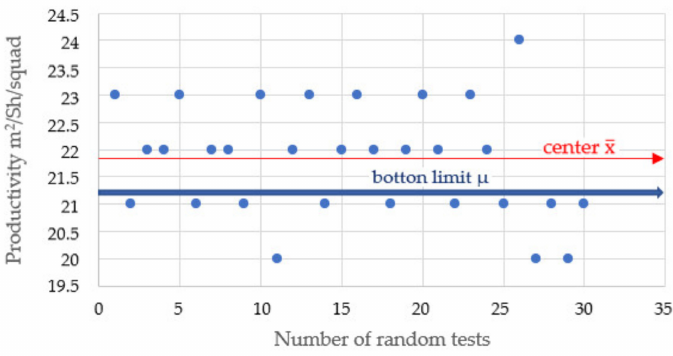
Figure 7. Graphic illustration of formwork performances, including the mean